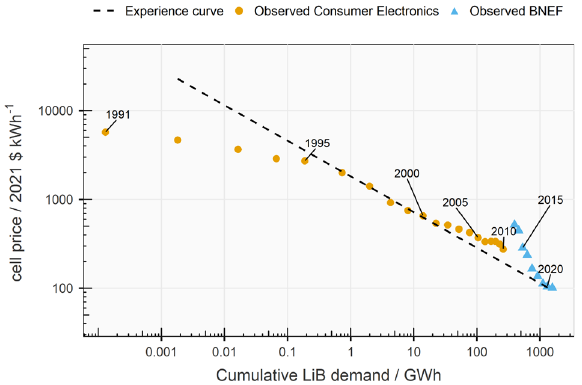
Fig. 1|Observedlithium-ionbatterycellprices1991-2021. “ ObservedConsumer electronics ” pricedatacomesfromref. 8 andre fl ectsthepricespaidforcellsusedin consumer electronics between 1991 and 2010. “ Observed BNEF ” price data comes fromref. 197 andre fl ectstheaveragepricepaidforcellsusedinelectricvehiclesand stationarystorageapplications. “ Experiencecurve ” showsthebatterypricedecline trend as deployments increase. The relationship is described by Wrights-law and shows thateverytime the cumulative volume of cellsdeployeddoubles, prices fall by 25%. Prices have been converted to real 2021 US $.